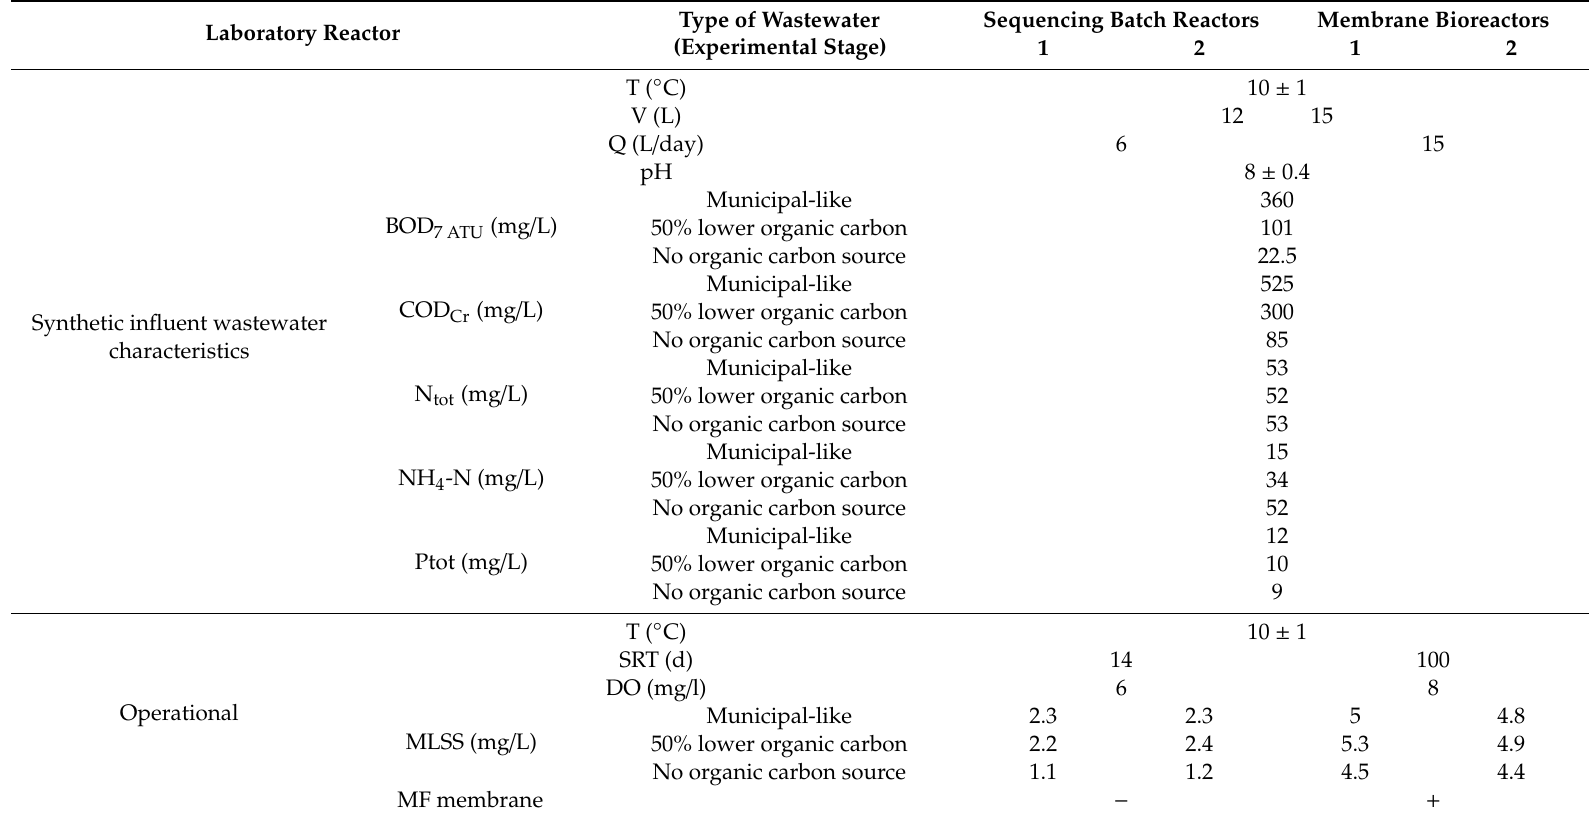
Table 2. The main operational parameters of the pilot-scale